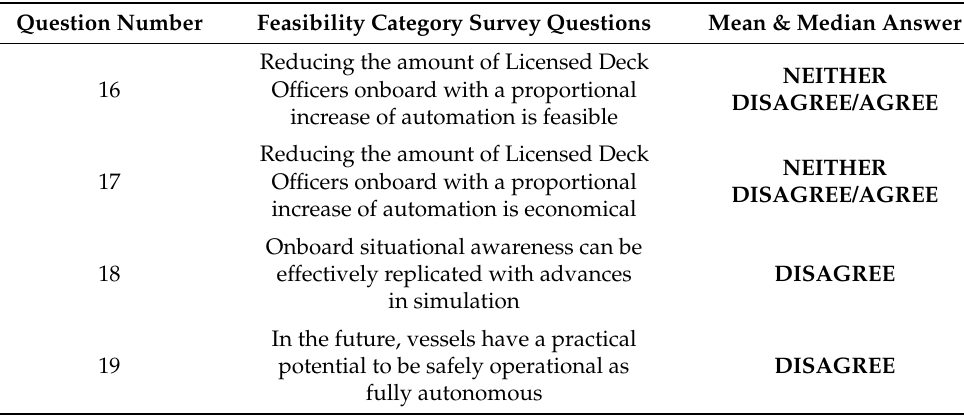
Table 3. Feasibility Category survey questions and response results.